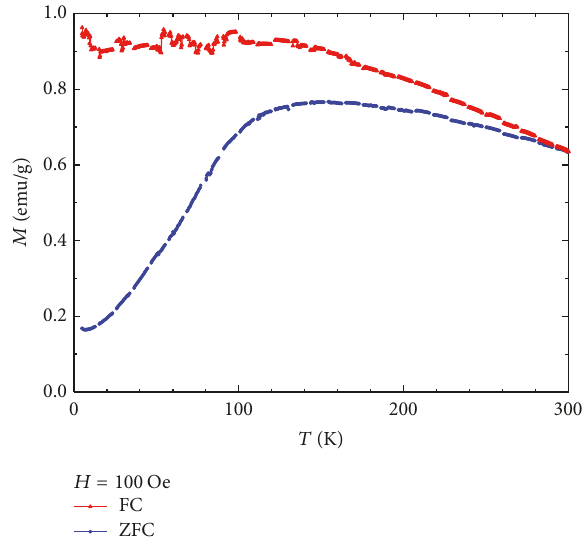
Figure 10: ZFC–FC curves measured in an applied field of 100Oe for CoNPs (12: 1).